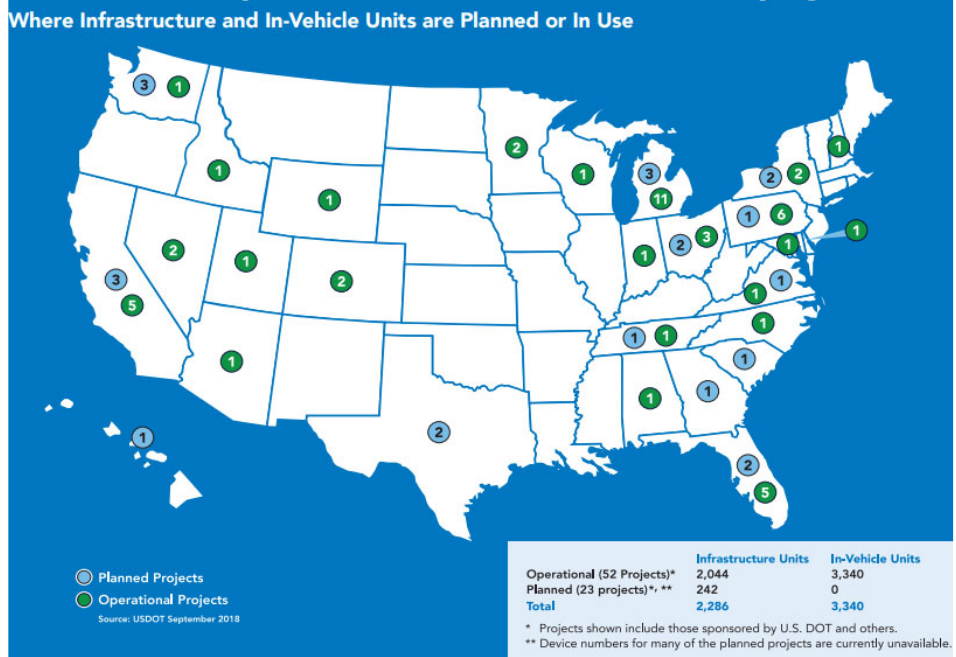
Figure 5. Planned and operational vehicle deployments where Infrastructure and In-vehicle units are planned or in use [54]. (number in the figure describes the units of planned and operational connected vehicle deployments)